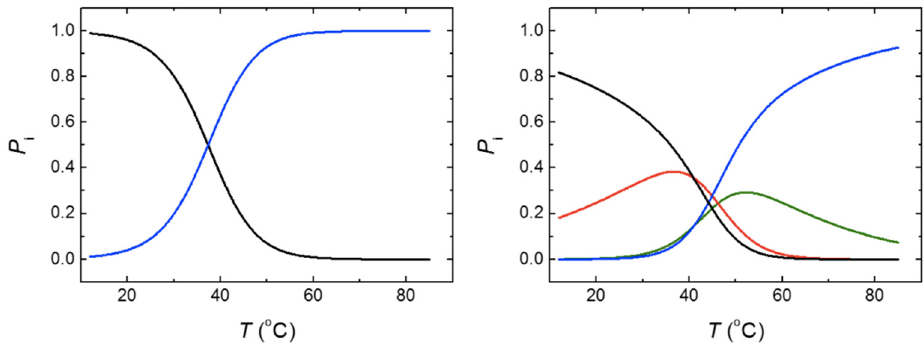
Figure 7. Molar fraction or population ( P i ) of the different conformational states: native state (black), first intermediate state (red), second intermediate state (green), and fully unfolded state (blue), for MBD (left) and for NTD-MBD-ID (right). Populations were calculated with the parameters shown in Table 2.